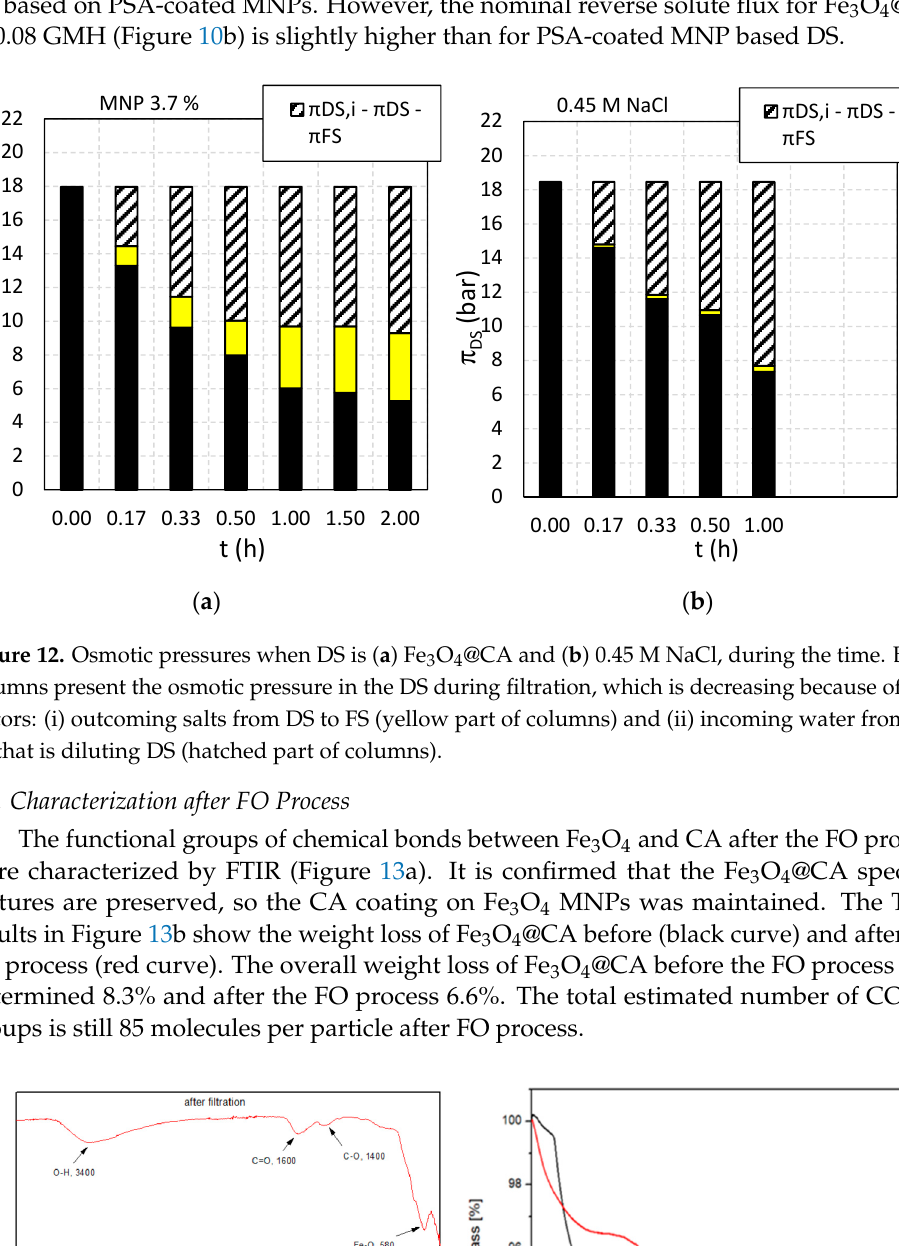
Figure 11. Osmotic pressures as function of time for ( a ) FS and ( b ) DS for 0.45 M NaCl and Fe 3 O 4 @CA as DS and DI water as FS, respectively.